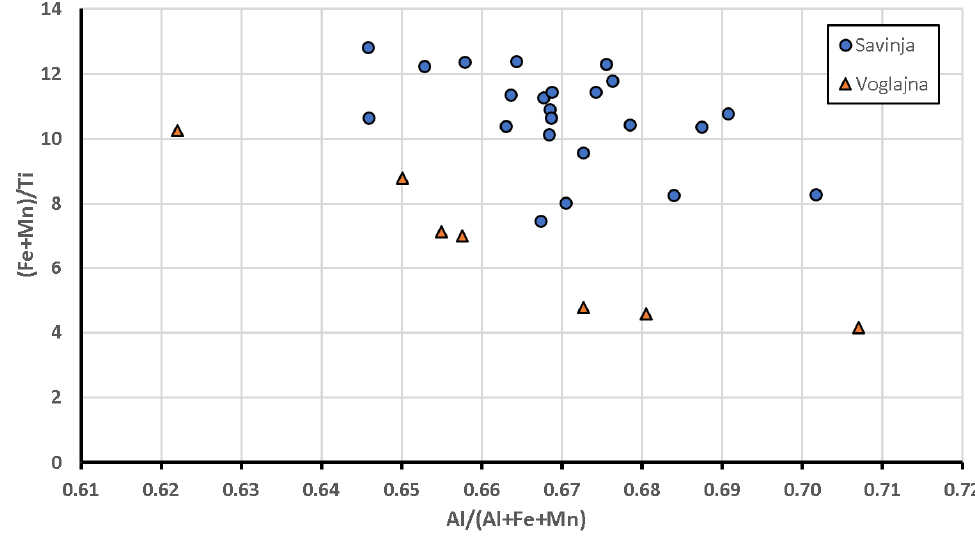
Figure 4. Scaling of the Al/(Al + Fe + Mn) and (Fe + Mn)/Ti ratios for the Savinja and Voglajna stream sediments.